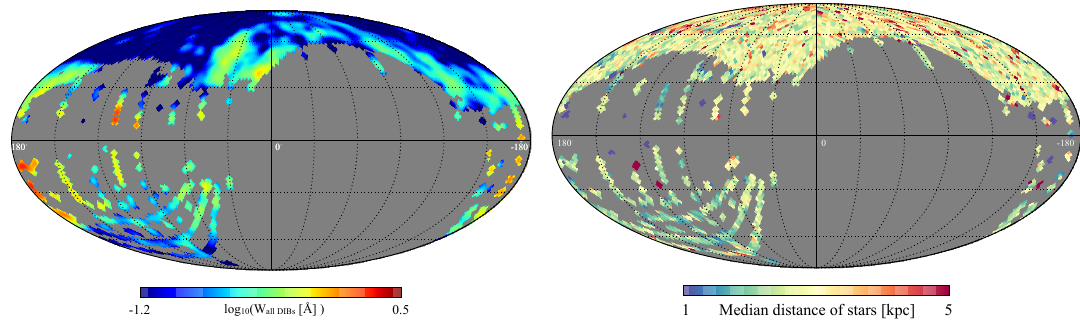
Figure 7. ( Left ) The full sky map of cumulative DIB absorptions (combined in total of 20 DIB lines) smoothed with a 5 ◦ -gaussian kernel; the map includes regions with E ( B − V ) > 0.02; ( Right ) the map showing median distance to the SDSS stars used in the coverage [78]. Clearly seen is that in the area of HI tongues neighbouring the X-ray NPS, the median distance is fairly flat of (cid:39) 2.5 kpc with a weak patchy deviations. Both maps are from